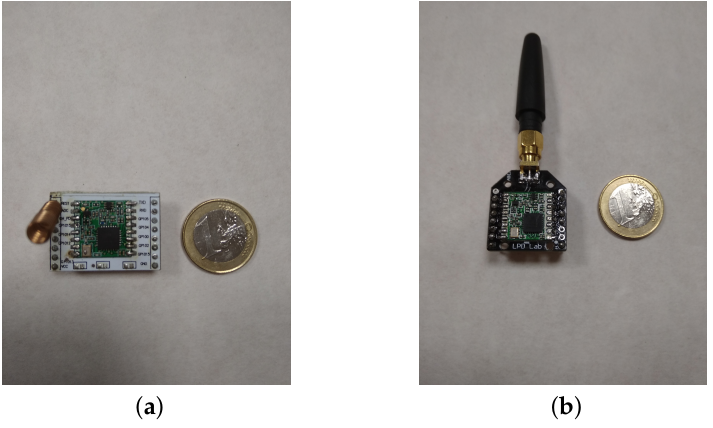
Figure 3. Dispatching data packets: implemented transceivers. ( a ) RFM95 with an ESP8266 module adapter. ( b ) HOPE RFM95W transceiver with breakout board and 868 MHz